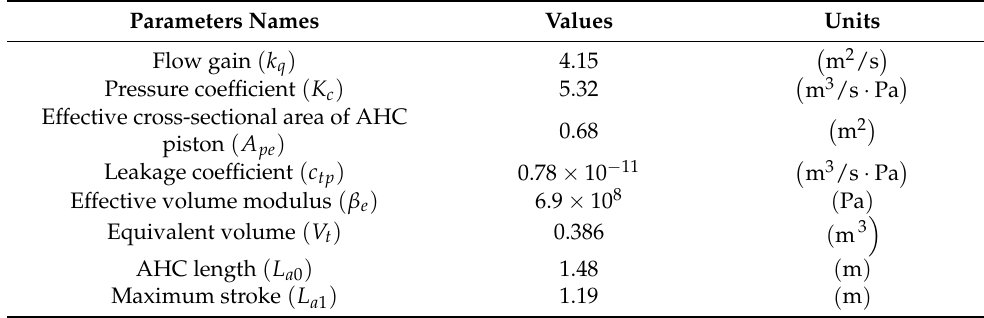
Table 1. Parameters of lateral AHC for ESR.